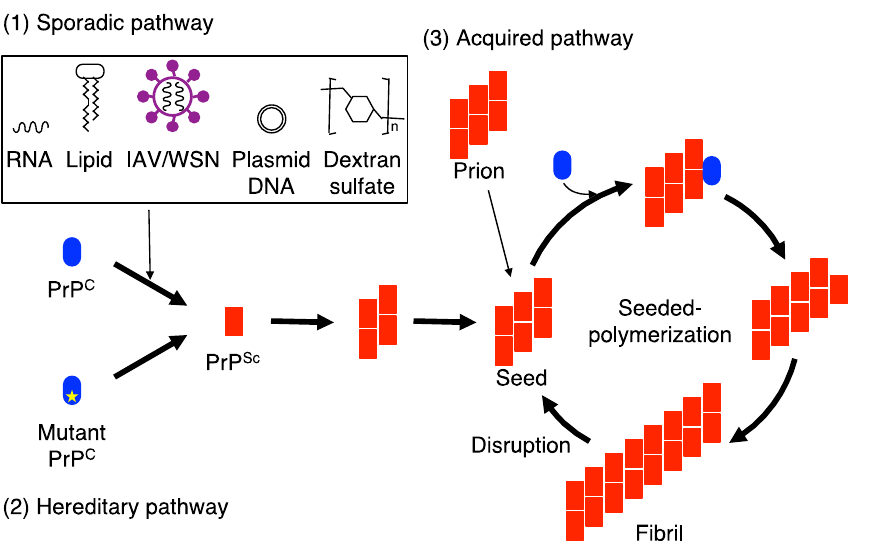
Figure 1. Seeded protein polymerization model for the conversion of PrP C into PrP Sc in sporadic, hereditary, and acquired prion diseases. (1) IAV/WSN infection and interaction with RNA, lipid molecules plasmid DNA and dextran sulfate drives PrP C to undergo conformational changes to form PrP Sc in sporadic prion diseases. (2) In hereditary prion diseases, mutated PrPs are prone to convert into PrP Sc . The nascently generated PrP Sc molecules in sporadic and hereditary prion diseases assemble to form small oligomeric PrP Sc aggregates and then further polymerize to form PrP Sc seeds, which are able to recruit and force PrP C to convert into PrP Sc on them. (3) In acquired prion diseases, exogenously invading prions function as PrP Sc seeds for the conversion of PrP C into PrP Sc . As a result, the PrP Sc oligomers are elongated to form fibrils in sporadic, hereditary, and acquired prion diseases. The fibrils are then disrupted into prions, or small PrP Sc seeds, which then enter the conversion cycle of PrP C into PrP Sc .